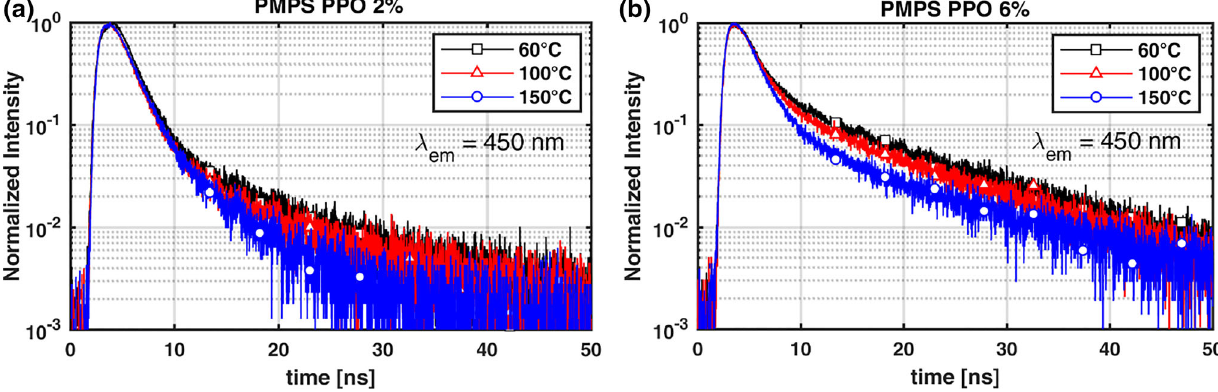
Fig. 5 Decay profiles of the fluorescence signal collected at 450 nm for the scintillators with 2% PPO (a) and 6% PPO (b) for different heating